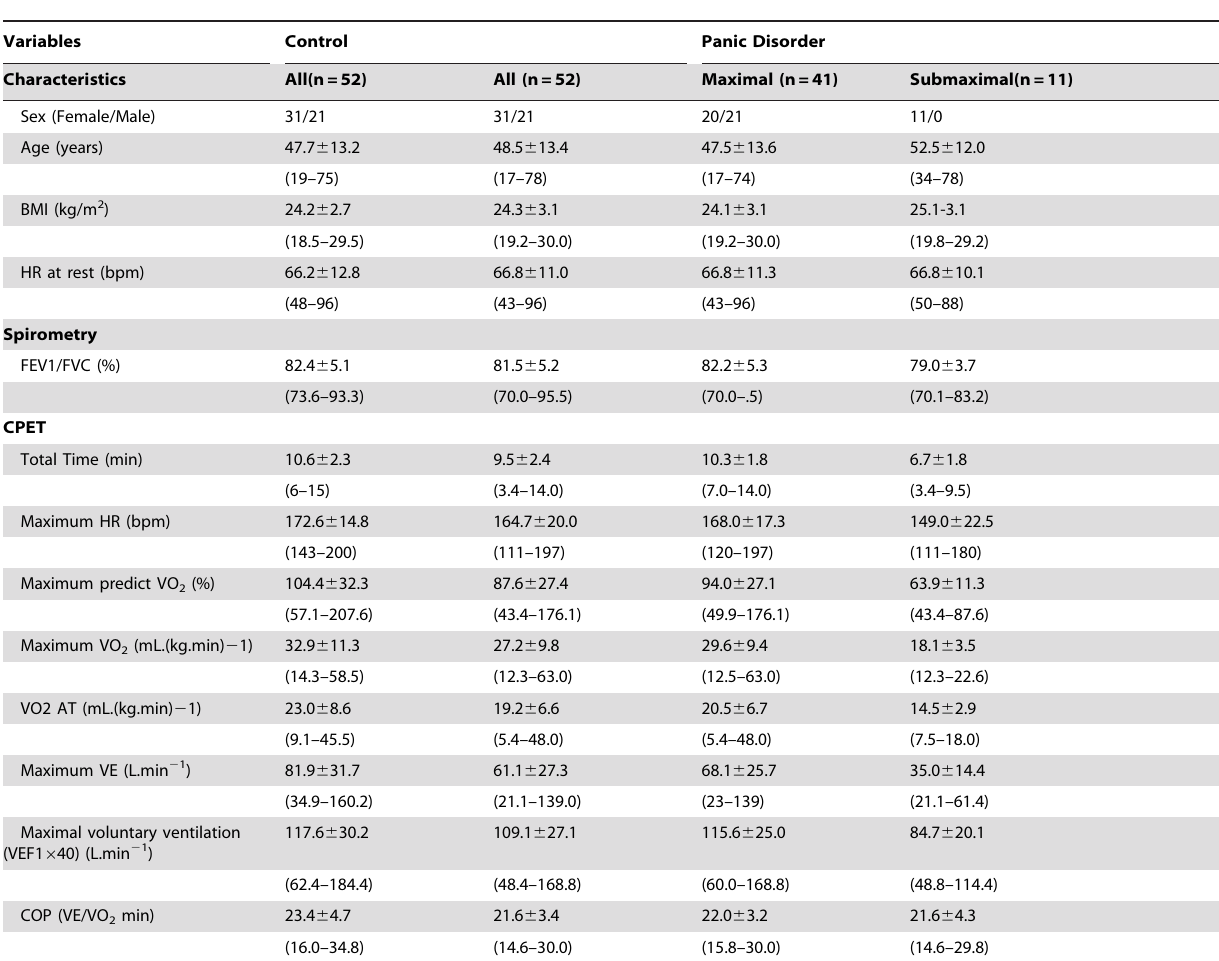
Table 1. Characteristics and main results for spirometry and CPET in groups and